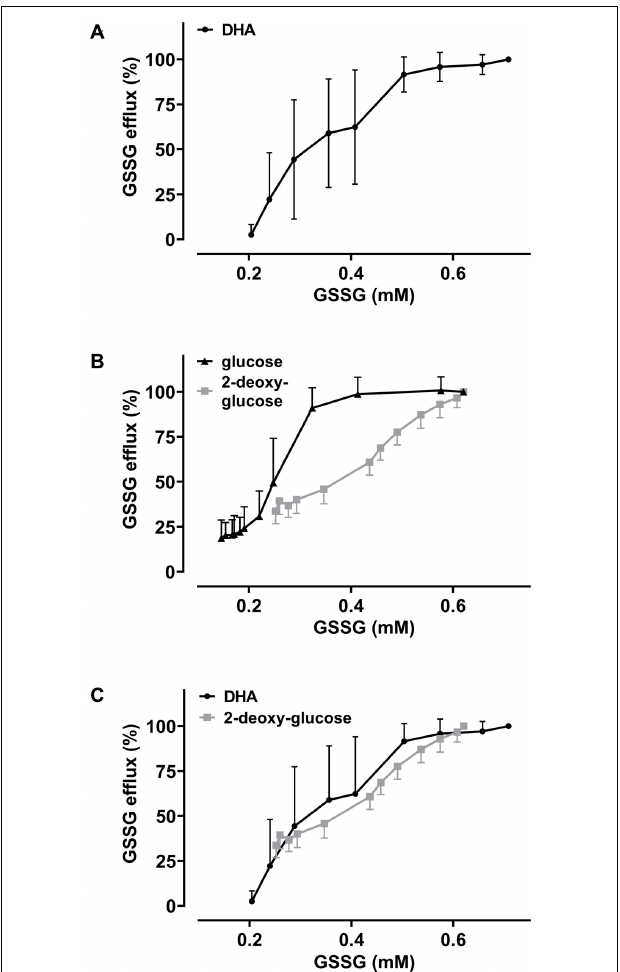
FIGURE 6 | The metabolic state of erythrocytes governs the dependency of GSSG efflux on intracellular GSSG content. Amount of cellular GSSG efflux in relation to cellular GSSG content upon DHA treatment in the absence and presence of glucose or 2-DG, respectively. Values were calculated from flow cytometry GSH depletion data ( Figure 3 ) and as described in the section “Results.” Data of GSSG efflux upon DHA treatment ( ± glucose or 2-DG, respectively) are derived from Figure 4 . Graphs combine these data to highlight the correlation of GSSG efflux with cellular GSSG content under various conditions. (A) Dependency of GSSG efflux on cellular GSSG levels upon pre-treatment of cells with various amounts of DHA (data from Figures 3C , 4B ). (B) Dependency of GSSG efflux on cellular GSSG levels upon pre-treatment of cells with 2 mM DHA and various amounts of glucose (black) or 2-DG (gray) (data from Figures 3D , 4D ). (C) Overlay of DHA (black) data from panel (A) with 2-DG (gray) data from panel (B)